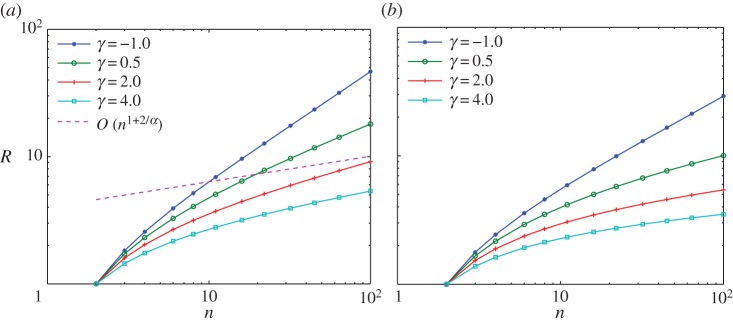
The dependence of the diameter  on the number of particles n: (a) α=−2.5; (b) α=−1.5. (Online version in colour.)